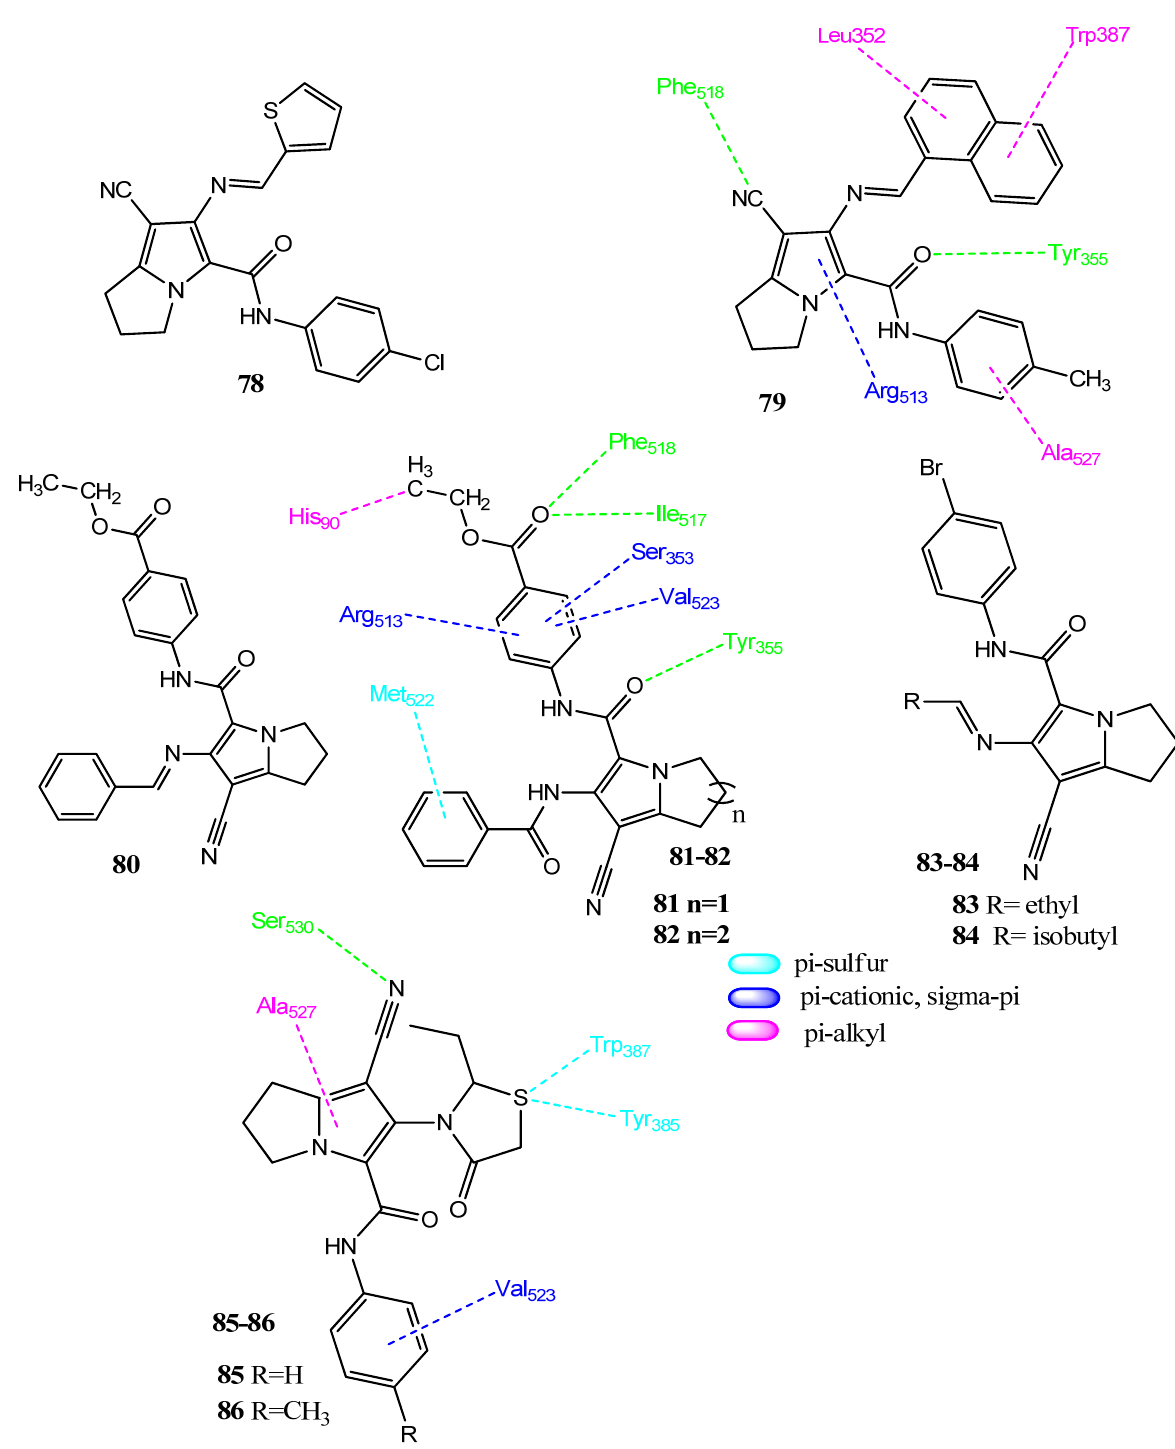
Figure 17. Pyrrolizine derivatives.